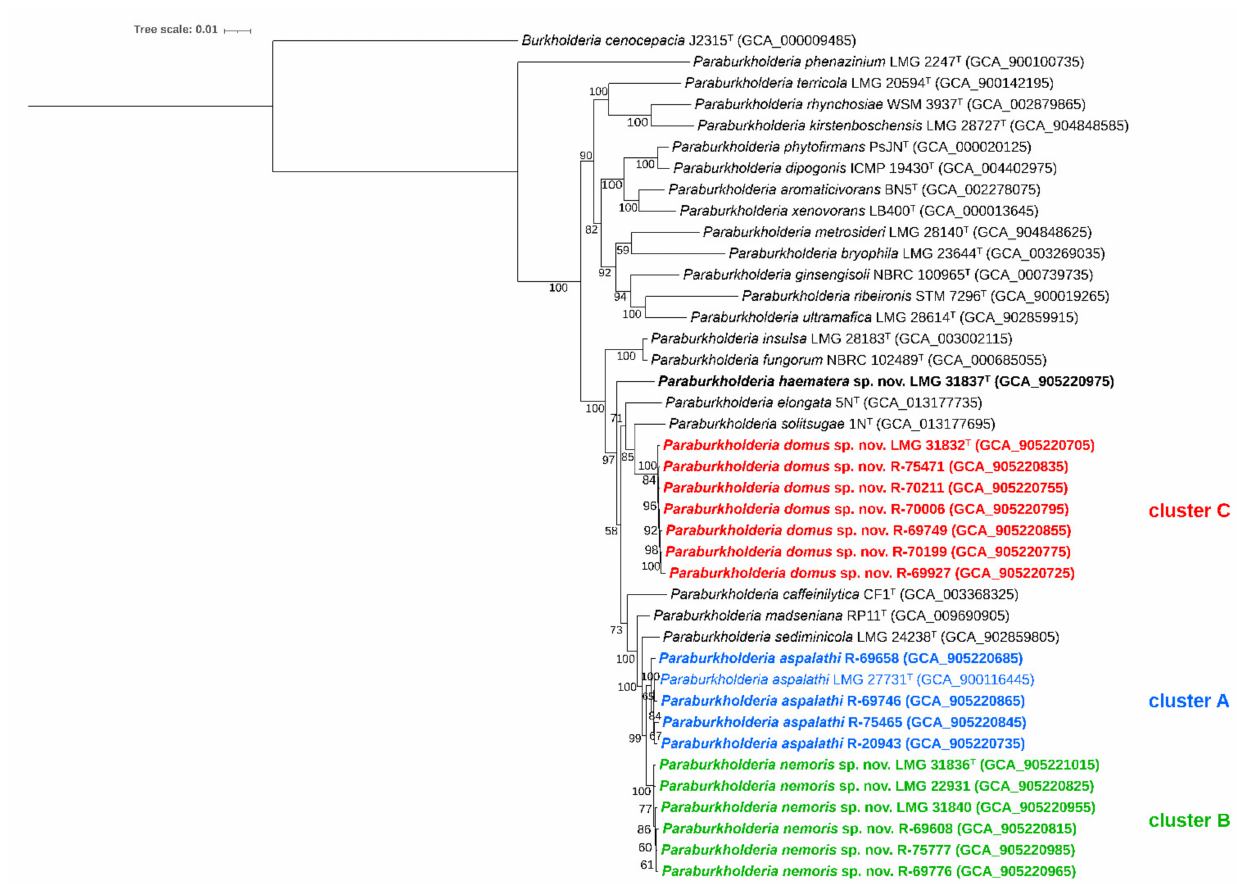
Figure 2. Phylogenomic tree based on 107 single-copy core genes. BcgTree was used to extract the nucleotide sequence of 107 single-copy core genes and to construct their phylogeny by partitioned maximum-likelihood analysis. The percentage of replicate trees in which the associated taxa clustered together in the bootstrap test (1000 replicates) are shown next to the branches. Eighteen isolates of the present study, the type strains of their nearest phylogenetic neighbor species and a selection of other Paraburkholderia type strains were included. Burkholderia cenocepacia J2315 T was used as outgroup. Strains reported in the present study are marked in bold character type. Bar, 0.01 changes per nucleotide